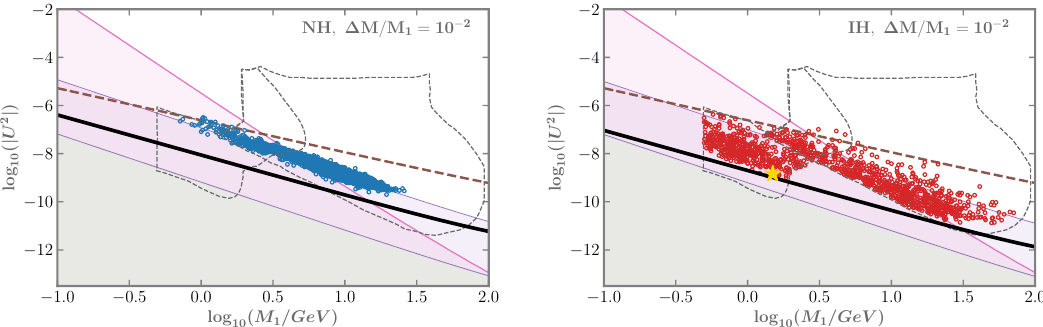
Figure 10 . Result of the numerical scan for ∆ M/M = 10 − 2 shown in blue (red) for NH (IH). The lower bound on the mixing imposed by the BAU in the fast oscillation regime is indicated by the black line, while there is an upper bound given by the requirement of having a slow flavour α at x EW . Color coding for the shaded regions as in figure 1.